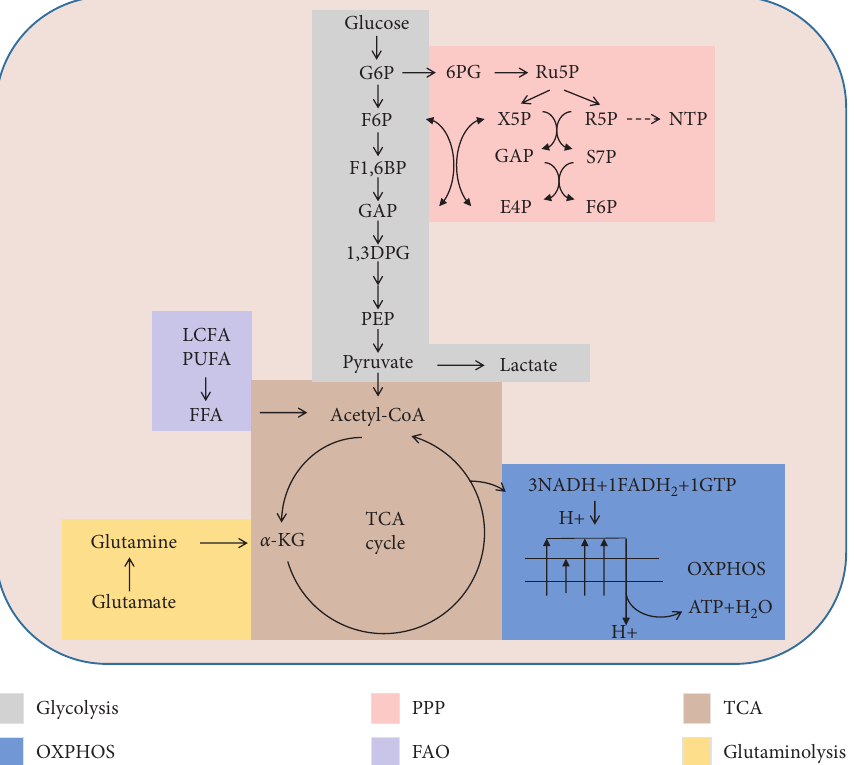
Figure 1: Significant metabolites colour-coded according to the pathway classification. Scheme of the glycolysis (GLY), pentose phosphate pathway (PPP), tricarboxylic acid (TCA) cycle, fatty acids oxidation (FAO), and glutaminolysis in the cell. All abbreviations are in Table